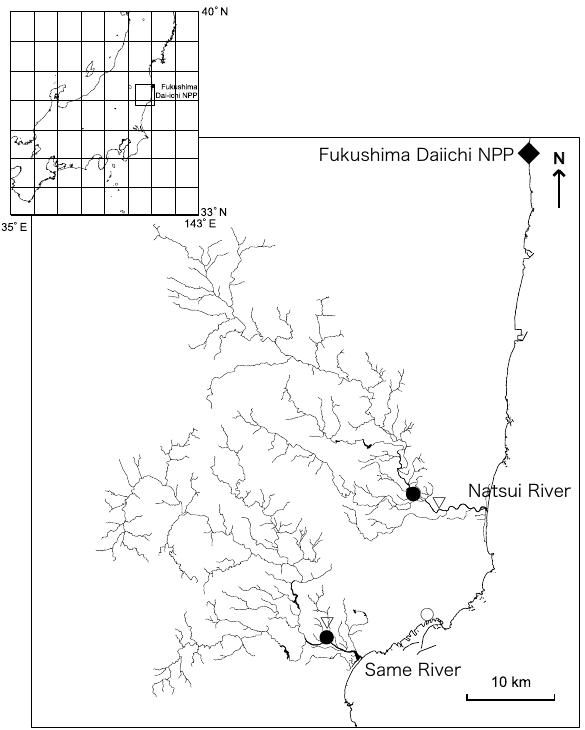
Fig. 1. Natsui River and the Same River sampling locations. Closed circles represent sampling stations. Open circles show a station for monitoring precipitation at Onahama. Open inverted triangles rep- resent water level observatory